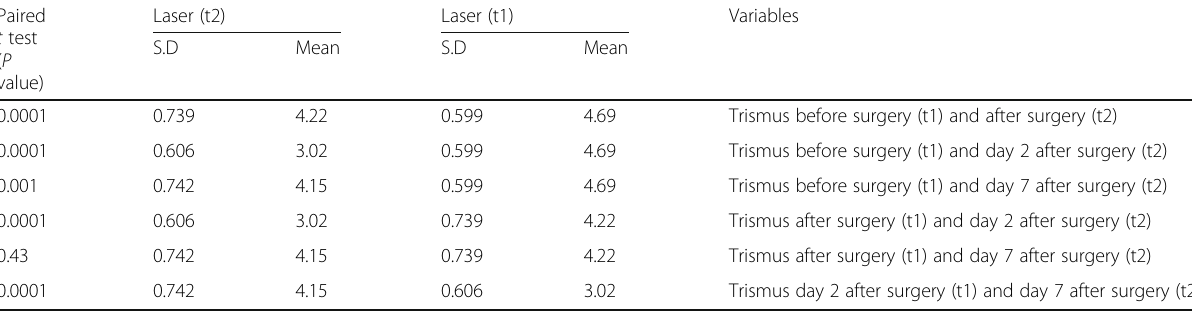
Table 8 Comparison of trismus variable at different times of laser surgery Paired Laser (t2) Laser t test ( P value)